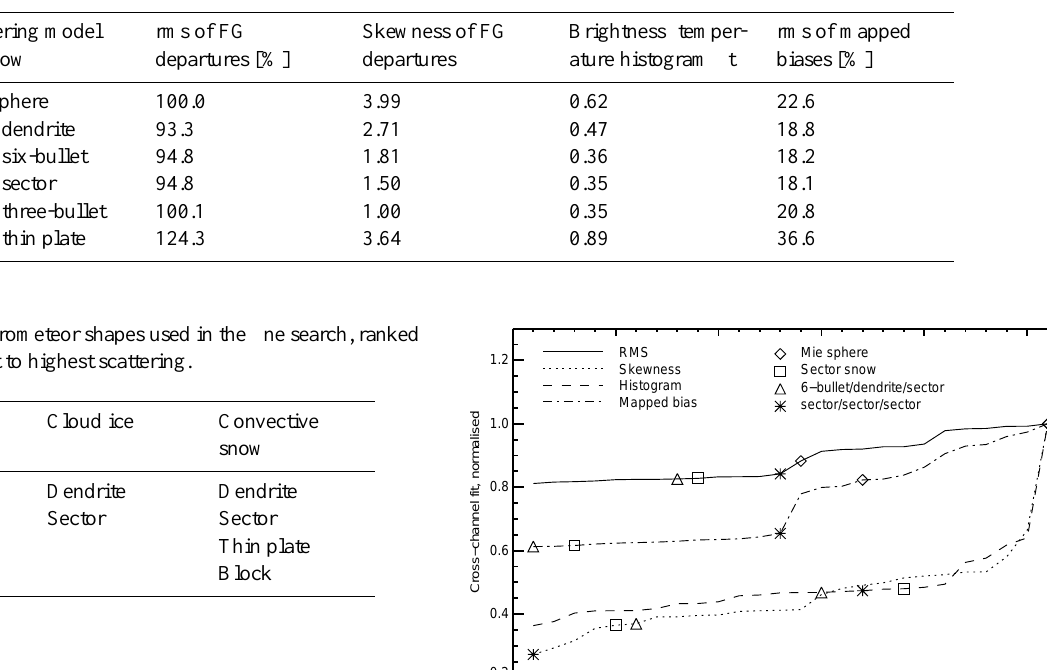
Table 2. Measures of fit between model and observations in the coarse search over ocean, summarised across all channels. To summarise the rms, histogram fit and rms of mapped biases, a mean is computed across all channels. For the skewness, an rms is computed across the channels. In all cases lower numbers indicate better agreement between model and observations.